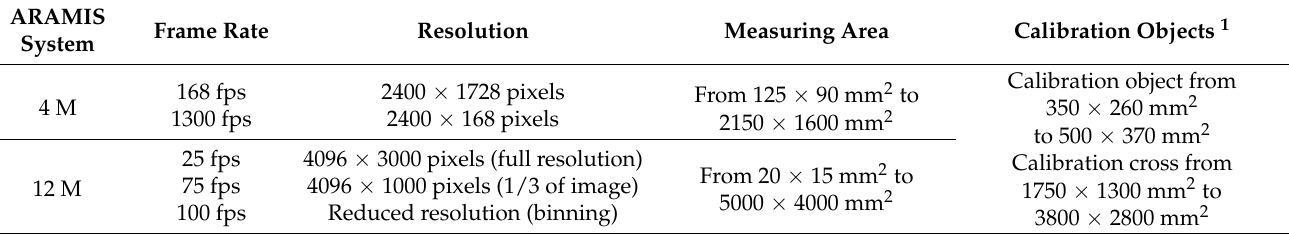
Figure 3. Both sets of high-speed cameras—ARAMIS 4 M (up) and ARAMIS 12 M (down). Table 4. Characteristics of the ARAMIS GOM high-speed camera